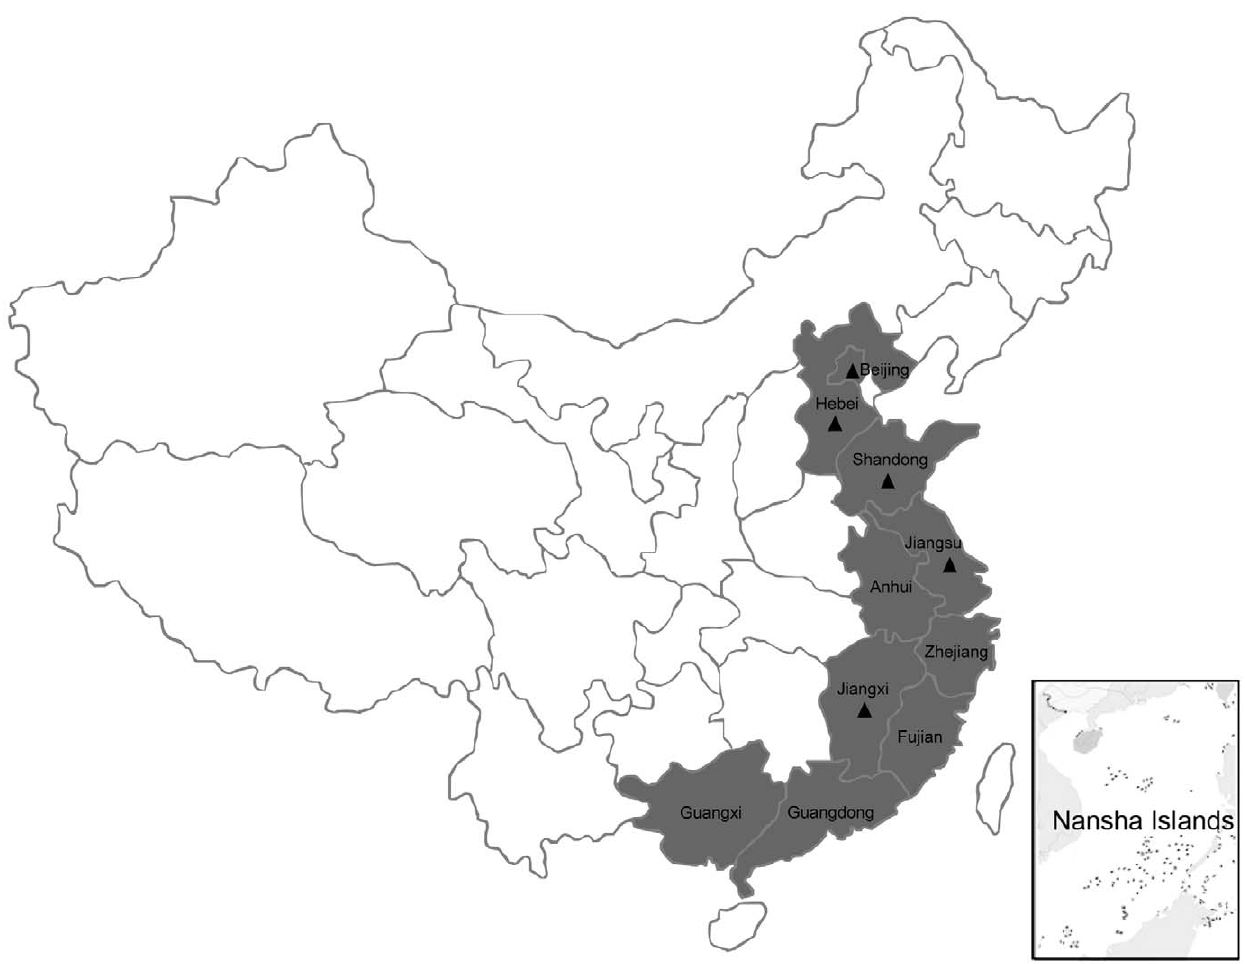
Figure 1. Regions of BYDV infection outbreaks in China. The provinces or autonomous cities (regions) affected are indicated in gray. Regions from which viruses were isolated and comfirmed by RT-PCR/sequencing are labeled with triangles.